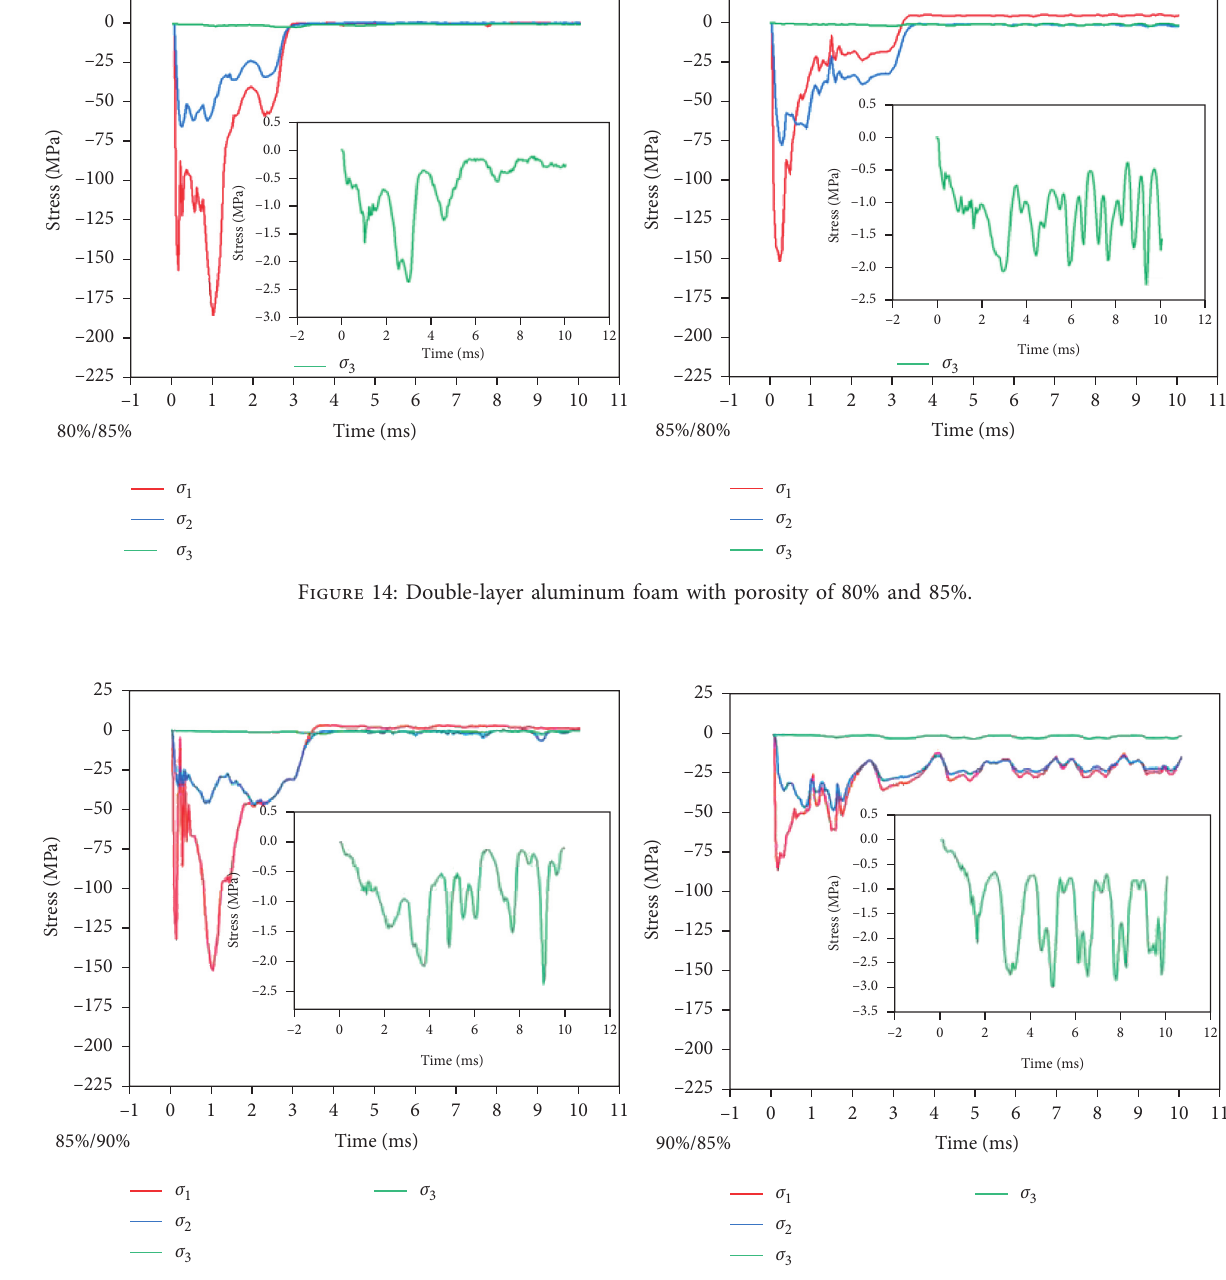
Figure 15: Double-layer aluminum foam with porosity of 85% and 90%.